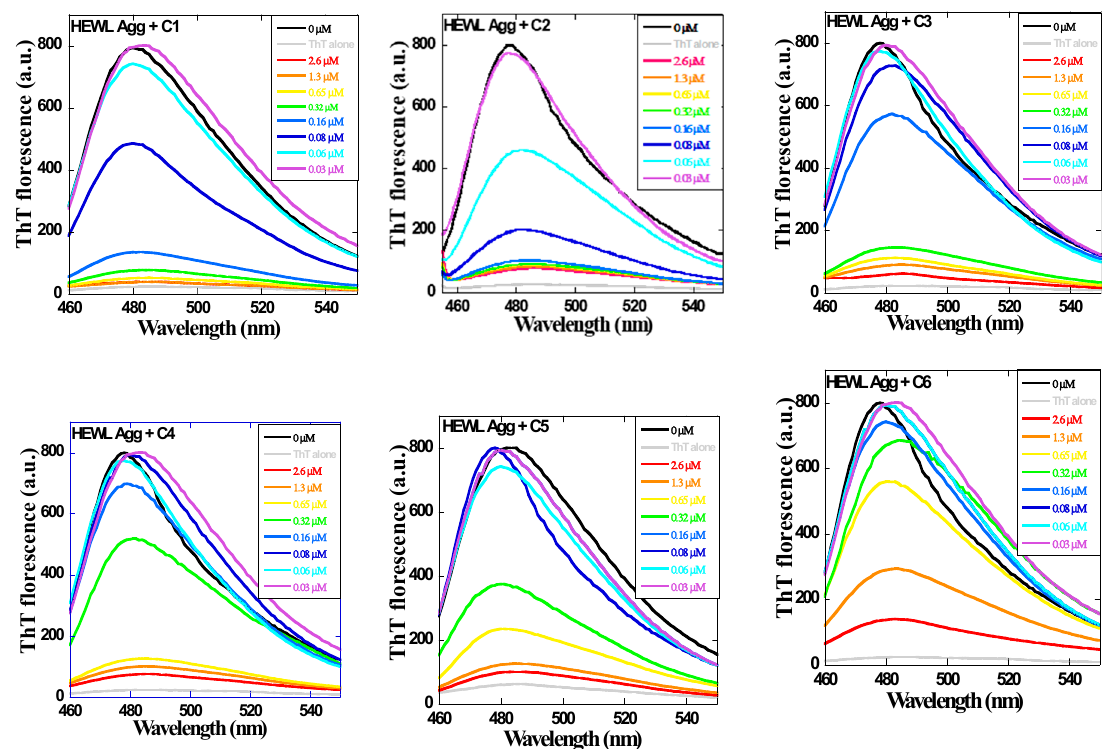
Figure 1. Dose-dependent inhibition of 0.03–2.6 µM compounds 1–6 on hen egg white lysozyme (HEWL) amyloid fibril formation at 2 mg/mL (140 µM), in 50 mM glycine buffer, pH 2.5, and 57 °C, under stirring (250 rpm), for 48 h, monitored by changes in thioflavin T (ThT) florescence intensity. The spectra refer to ThT alone (gray), HEWL pre-incubated with 0 (black), 0.03 (violet), 0.06 (indigo), 0.08 (dark blue), 0.16 (blue), 0.32 (green), 0.65 (yellow), 1.3 (orange), and 2.6 (red) µM of compounds 1–6.